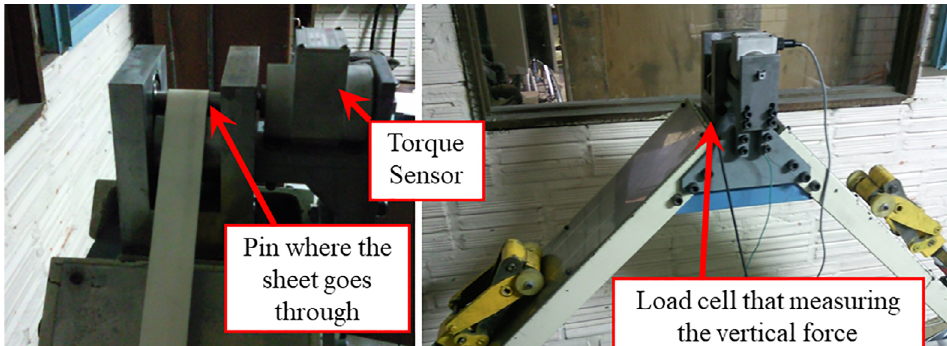
Figure 2 . Machine used to perform BUT test.